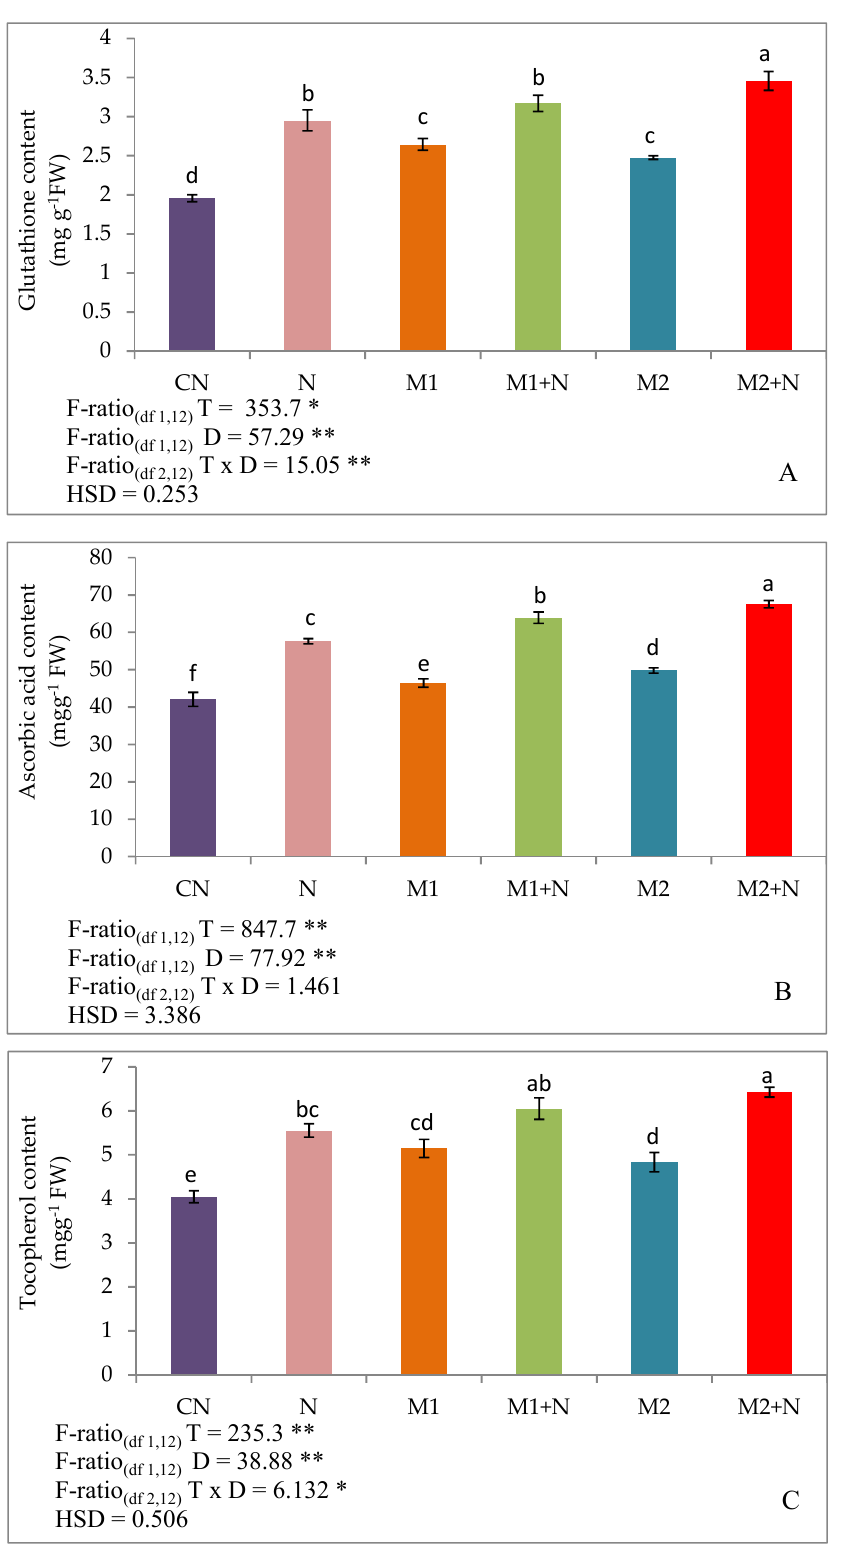
Figure 3. Effect of M1 (10 9 cells/ ml) and M2 (10 9 cells/ ml) on: ( A ) Glutathione content, ( B ) Ascorbic acid content and ( C ) Tocopherol content in 45-days old L. esculentum plants under PPN infection. Data is presented as means of three replicates ± SD and HSD values. F ratio values, * indicates significance at p ≤ 0.05 and ** indicates significance at p ≤ 0.01). Different letters on the graphs indicate that mean values of treatments are significantly different at p < 0.5 according to Tukey’s multiple comparison test.